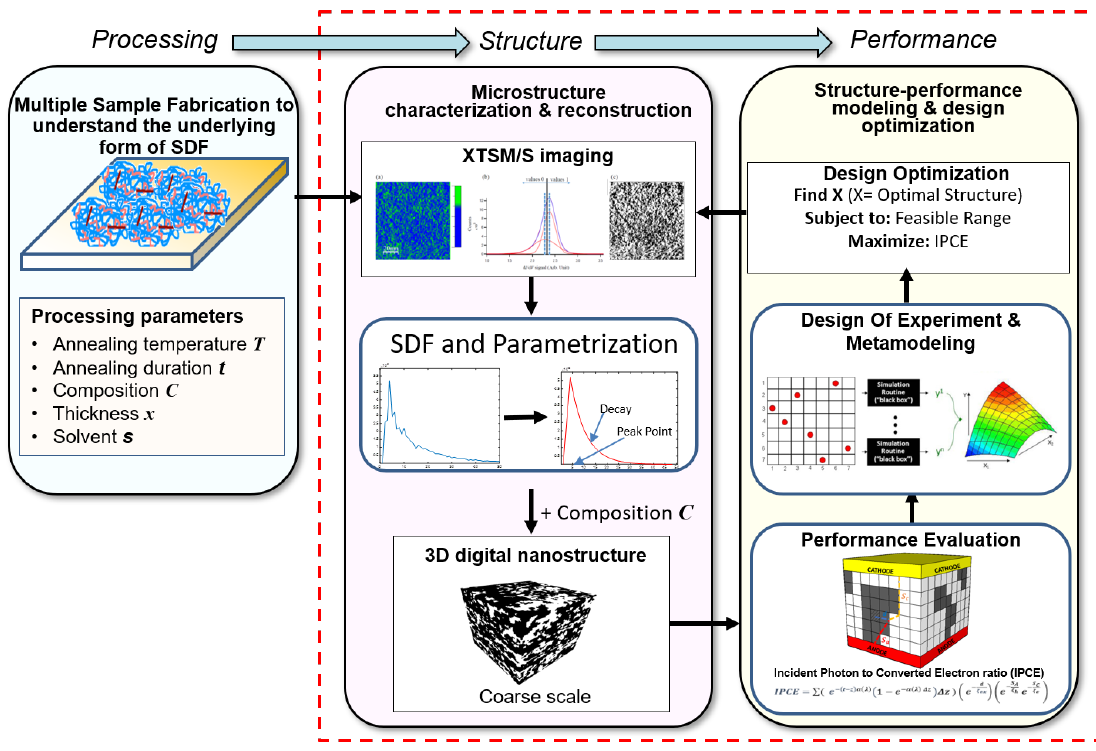
Figure 9. A framework for designing active layer of organic photovoltaic solar cells (OPVCs) via spectral density function. This figure is adapted with permission from Reference [128], copyright 2018 American Society of Mechanical Engineering. SDF = spectral density